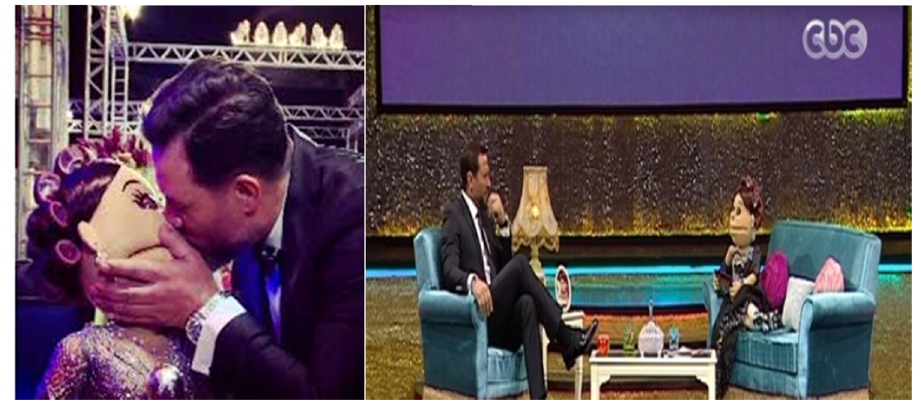
Figure 2: Abla Fahita with Maged